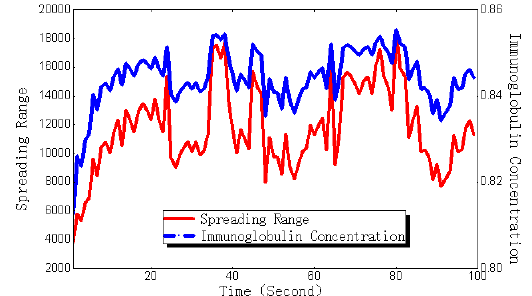
Fig. 7. Malicious JavaScript spreading range and corresponding immunoglobulin concentration.